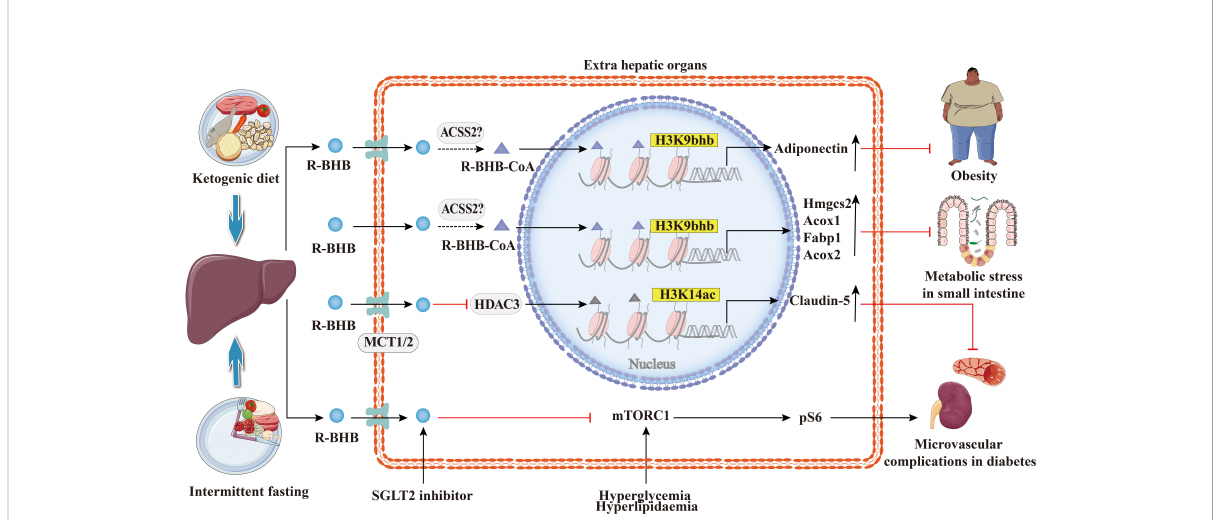
FIGURE 7 Histone Kbhb in metabolic diseases. Ketogenic diet and intermittent fasting promote BHB synthesis in the liver. BHB-induced H3K9bhb promotes adipocyte adiponectin gene expression and protects against obesity. BHB inhibits HDAC3 and leads to acetylation of H3K14 in the Claudin-5 promoter, thereby promoting Claudin-5 production and antagonizing diabetes-related cardiac microvascular hyperpermeability. Elevated BHB levels result in the enrichment of H3K9bhb within the regulatory regions of key metabolic genes in the small intestinal crypt cells. Elevated levels of BHB resulted in the concentration of H3K9bhb within the regulatory region of key metabolic genes in the epithelial cells of the small intestinal crypts. Furthermore, loss of HMGCS2 reversed the enrichment of H3K9bhb and affected the expression of H3K9bhb-related metabolic gene programs. SGLT2 inhibitors elevated BHB in vivo , which inhibited the mechanical target of rapamycin complex 1 (mTORC1) signaling (assessed by phosphorylation of S6 protein), resulting in alleviation of both non-proteinuric and proteinuric